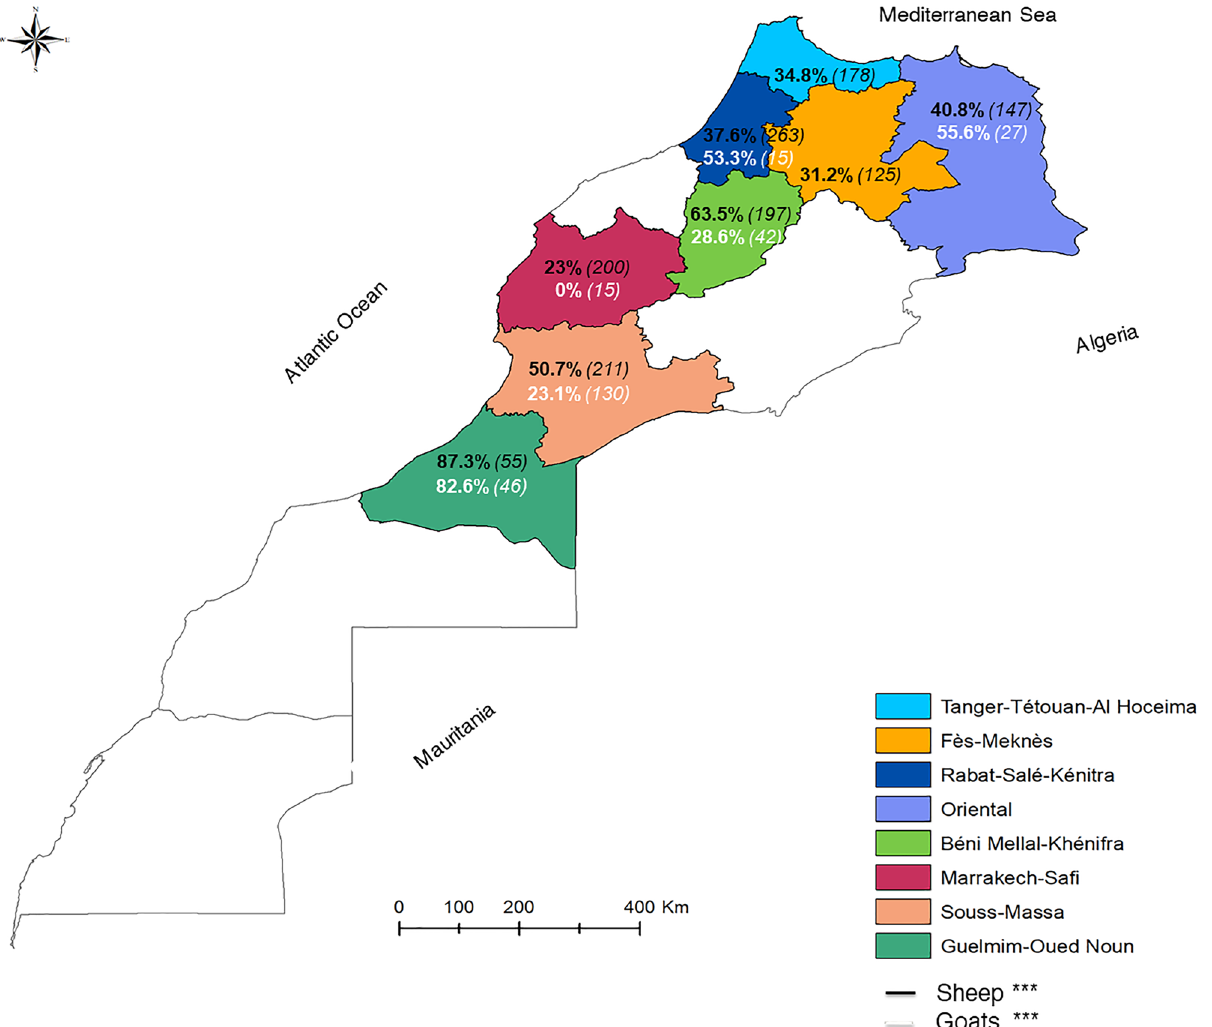
Figure 2. Bluetongue virus seroprevalences in sheep and goats during March 2018–July 2021 in Morocco. Black and white colors indicate BTV seroprevalence in sheep and goats, respectively (in brackets, the number of samples screened).The statistical significance between rates is indicated as ***P <